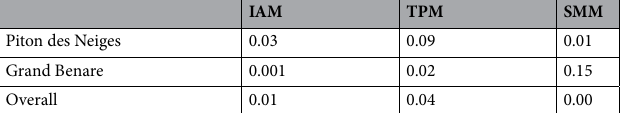
Table 2. P values from two tailed Wilcoxon sign-rank test of significance based on expected heterozygosity excess approach assuming mutation-drift equilibrium at the null hypothesis, and employing the Infinite Allele (IAM), Two-phase (TPM) and Stepwise Mutation (SMM)